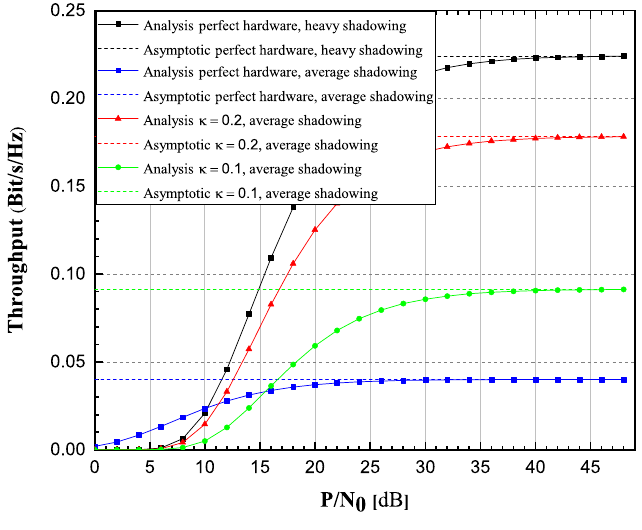
Figure 7. Rician-shadowed fading channels: Achievable throughput versus P / N 0